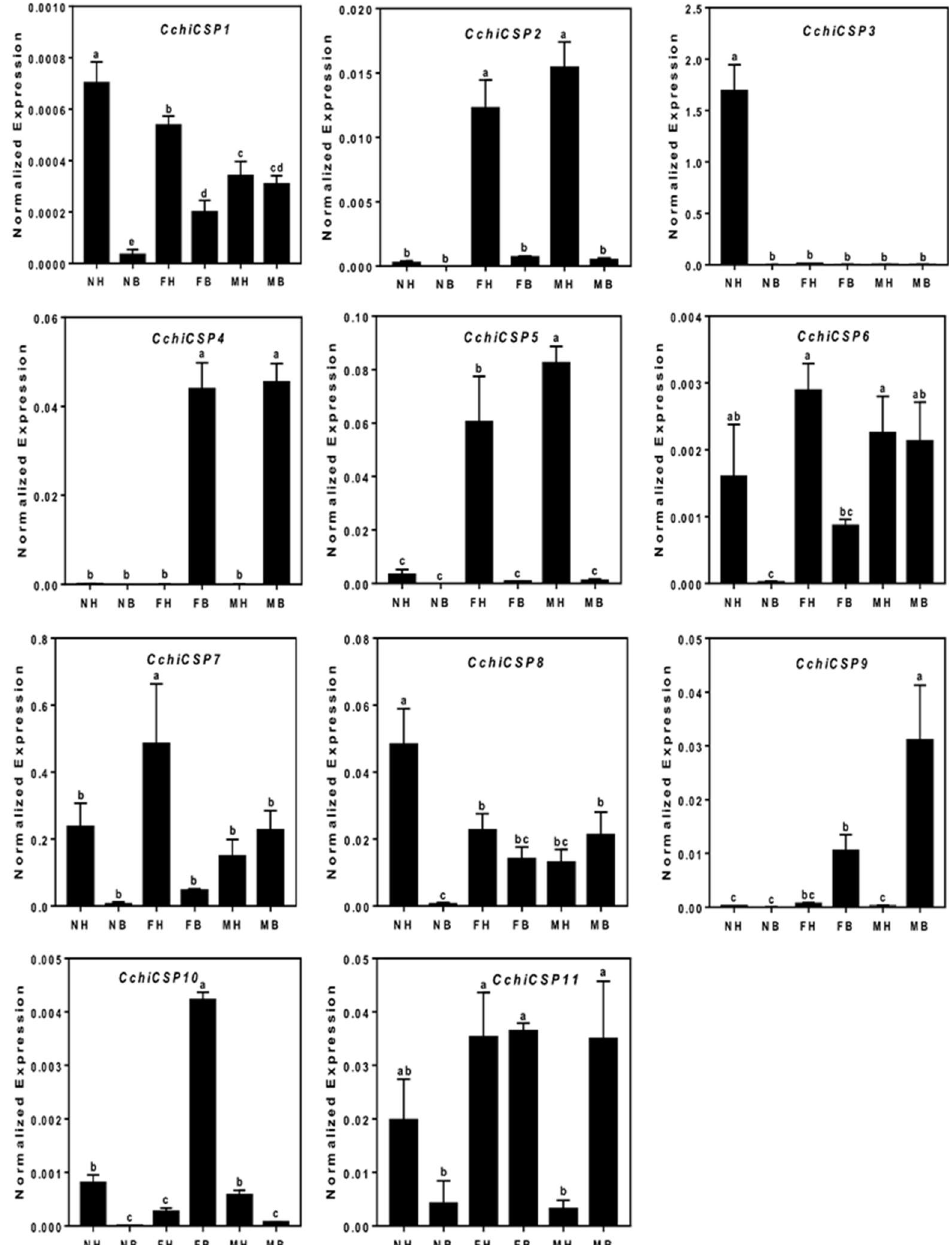
Figure 6. The tissue expression of CSP genes in C. chinensis . The different lowercase letters mean significance between tissues ( p < 0.05, ANOVA, LSD). NH, nymph head; NB, nymph body; FH, female head; FB, female body; MH, male head; MB, male body.